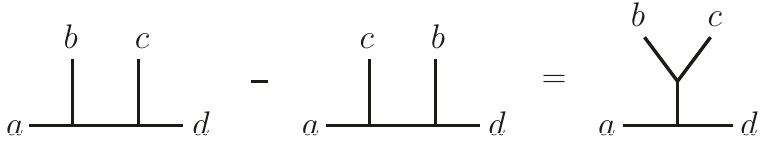
Figure 6 . The Jacobi relation for a group of three graphs. The graphs can represent color factors or numerator factors and can be thought of as embedded in a larger